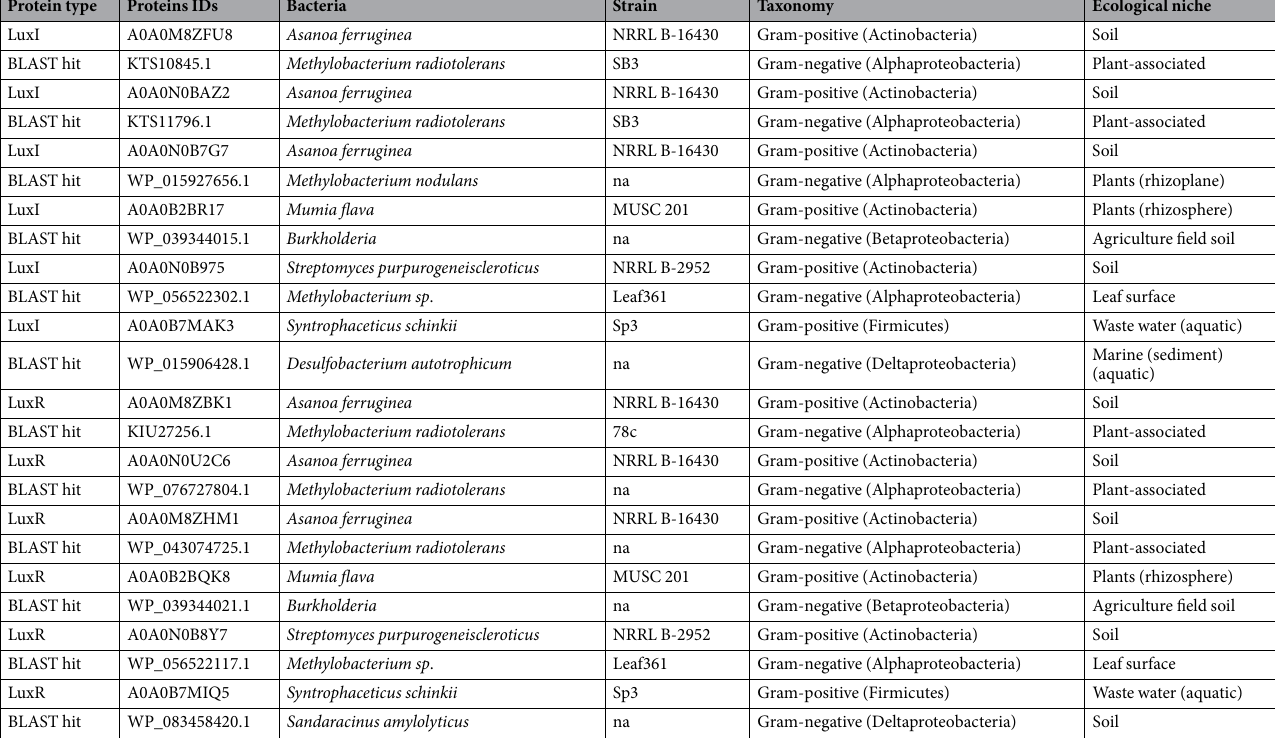
Table 2. Table displaying protein type, IDs, organism name, topological orientation, ecological niche and taxonomic details of Gram-positive bacteria (06 LuxI and their cognate LuxR) and their corresponding top- most BLAST hit Gram-negative